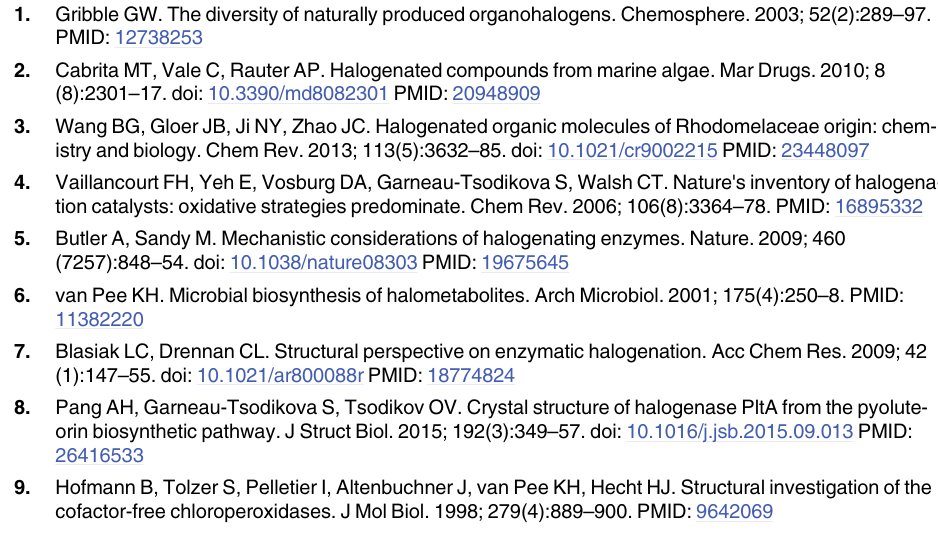
S6 Fig. Structure comparison of the V-HPO and the acid phosphatase. (PDF) S7 Fig. Multiple sequence alignment of the HI-HPO and the peroxidases. (PDF) S8 Fig. Structure comparison of the HI-HPO and the peroxidases. (PDF) S9 Fig. Multiple sequence alignment of the NI-HG and the chemotaxis phosphatases. (PDF) S10 Fig. Structure comparison of the NI-HG and the chemotaxis phosphatase. (PDF) S11 Fig. Multiple sequence alignment of the F-HG and the oxidoreductases. (PDF) S12 Fig. Structure comparison of the F-HG and the oxidoreductases. (PDF) S13 Fig. Multiple sequence alignment of the S-HG and the SAM hydroxide adenosyltrans- ferases. (PDF) S14 Fig. Structure comparison of the S-HG and the SAM hydroxide adenosyltransferases. (PDF) S1 Table. Six families of halogenating enzymes.